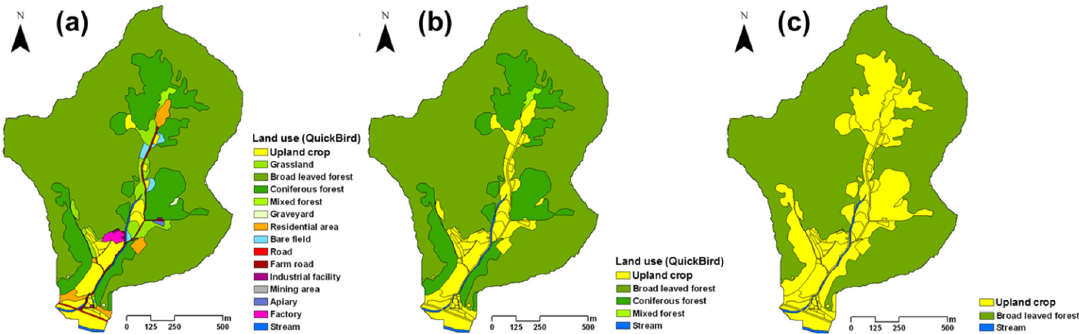
Figure 4. Comparison of the land use change areas in ( a ) baseline, ( b ) Scenario 1, and ( c ) Scenario 2.